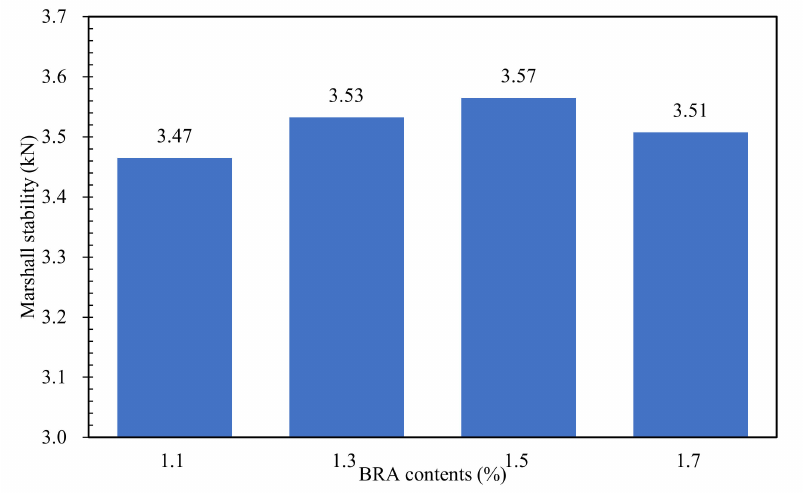
Figure 4. Effects of BRA dosages on the mechanical properties of BRA-rejuvenated